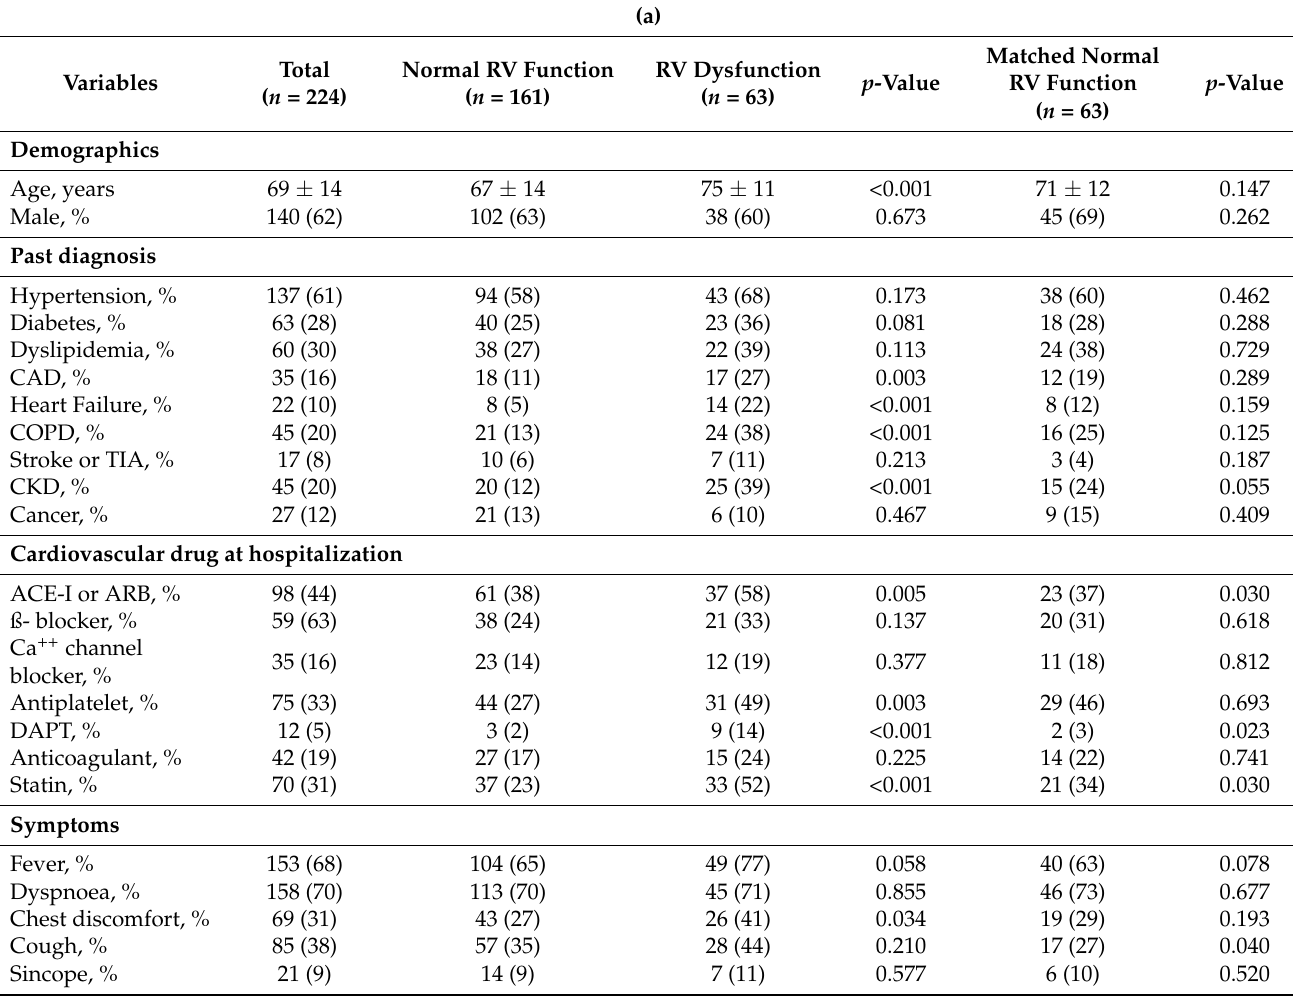
Table 1. ( a ) Clinical data ( b ) Echocardiographic data.